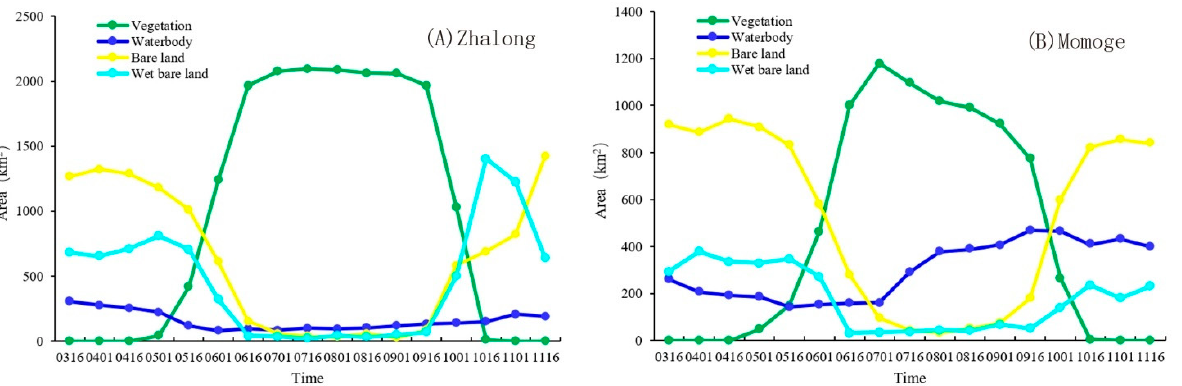
Figure 8. Changes in four landcovers area for Zhalong National Nature Reserve and Momoge National Nature Reserve. Note: The times marked in the figure are the first dates of the 15-day Sentinel-2 composite